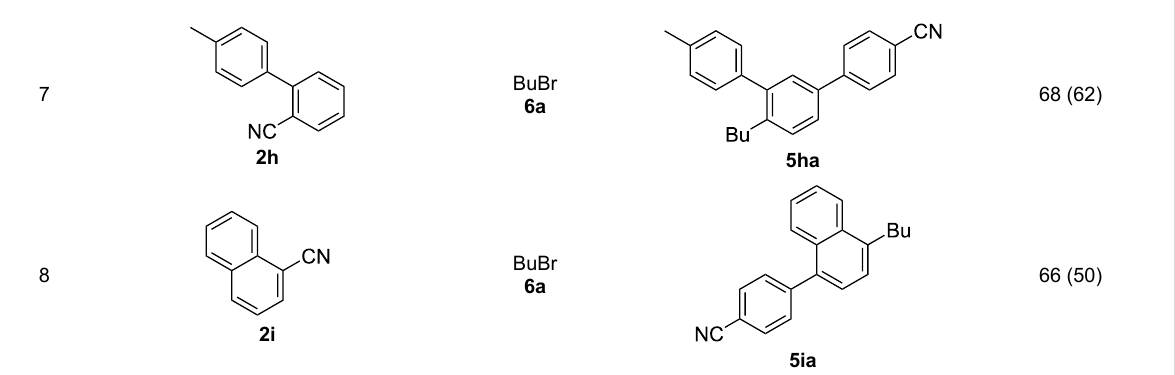
Table 2: Interaction of dianion 1 2 – with cyanoarenes 2b – i , followed by alkylation of intermediate anions 3b–i with butyl bromide 6a . (continued)